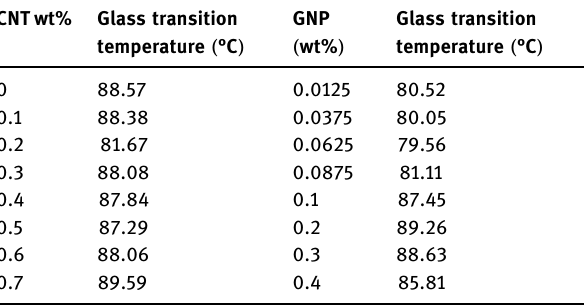
Table 4: Glass transition temperature for di ff erent materials